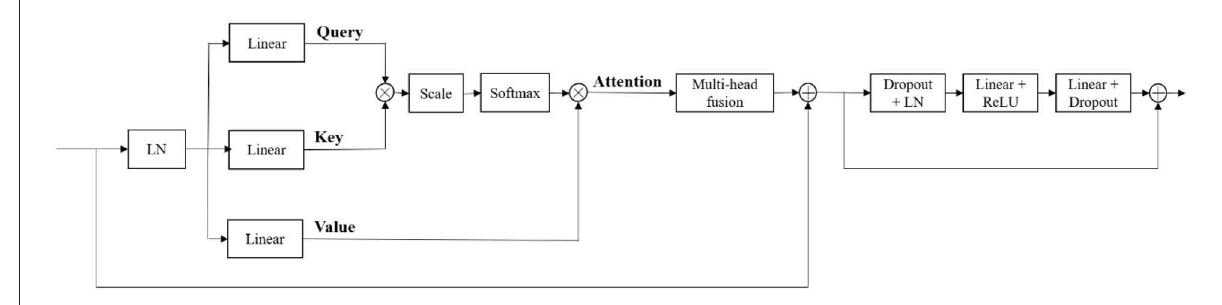
FIGURE2 The structure of transformer